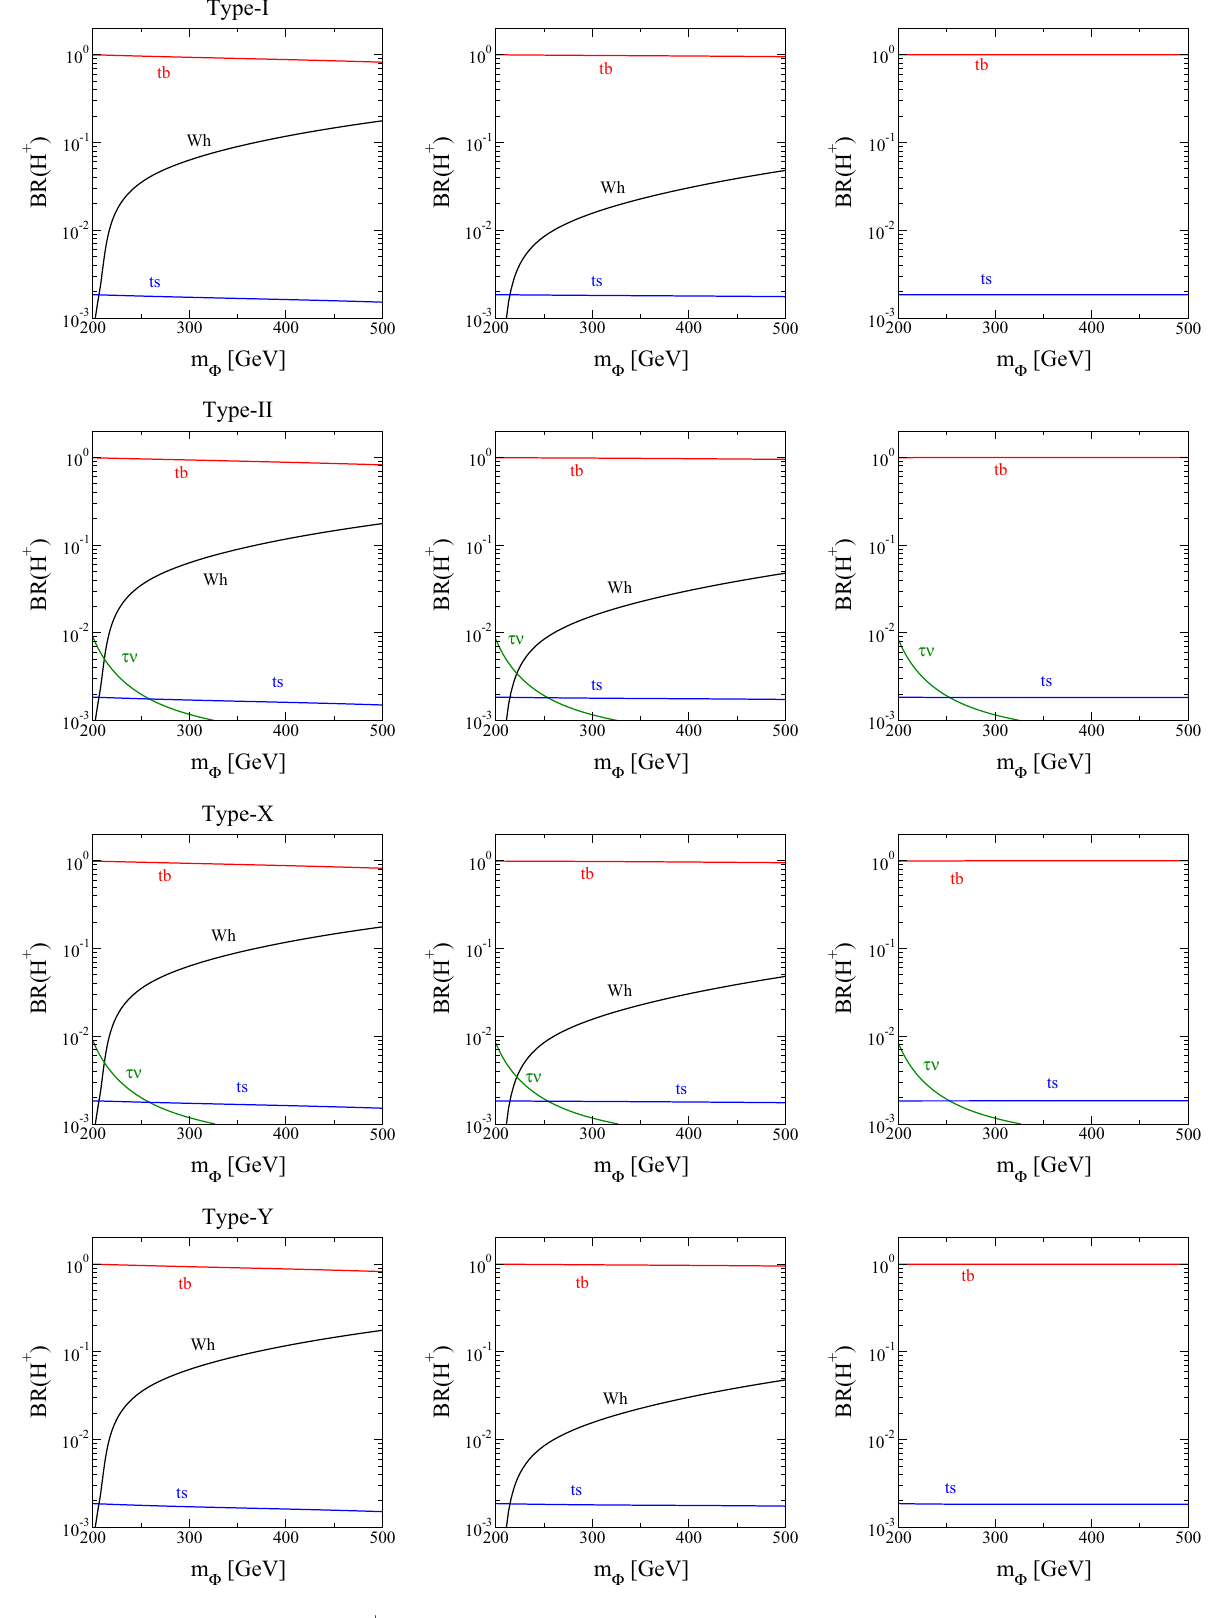
Fig. 7 Same as Fig. 5, but for the BRs of H